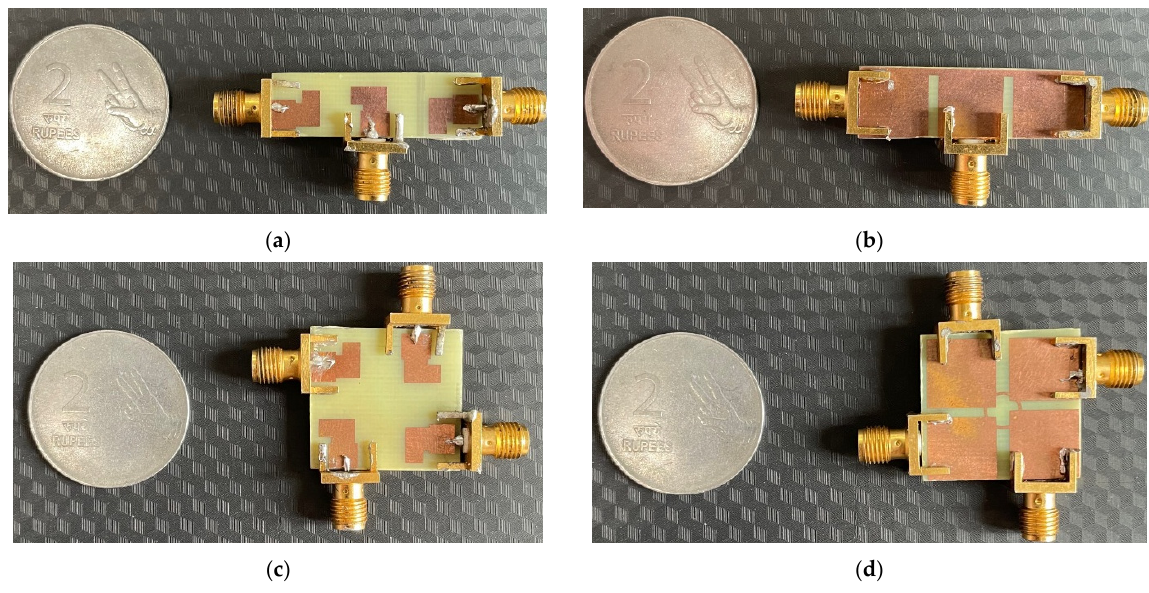
Figure 13. Prototype realization. ( a ) Three-element MIMO antenna—top view; ( b ) three-element MIMO antenna—bottom view; ( c ) four-element MIMO antenna—top view; ( d ) four-element MIMO antenna—bottom view.